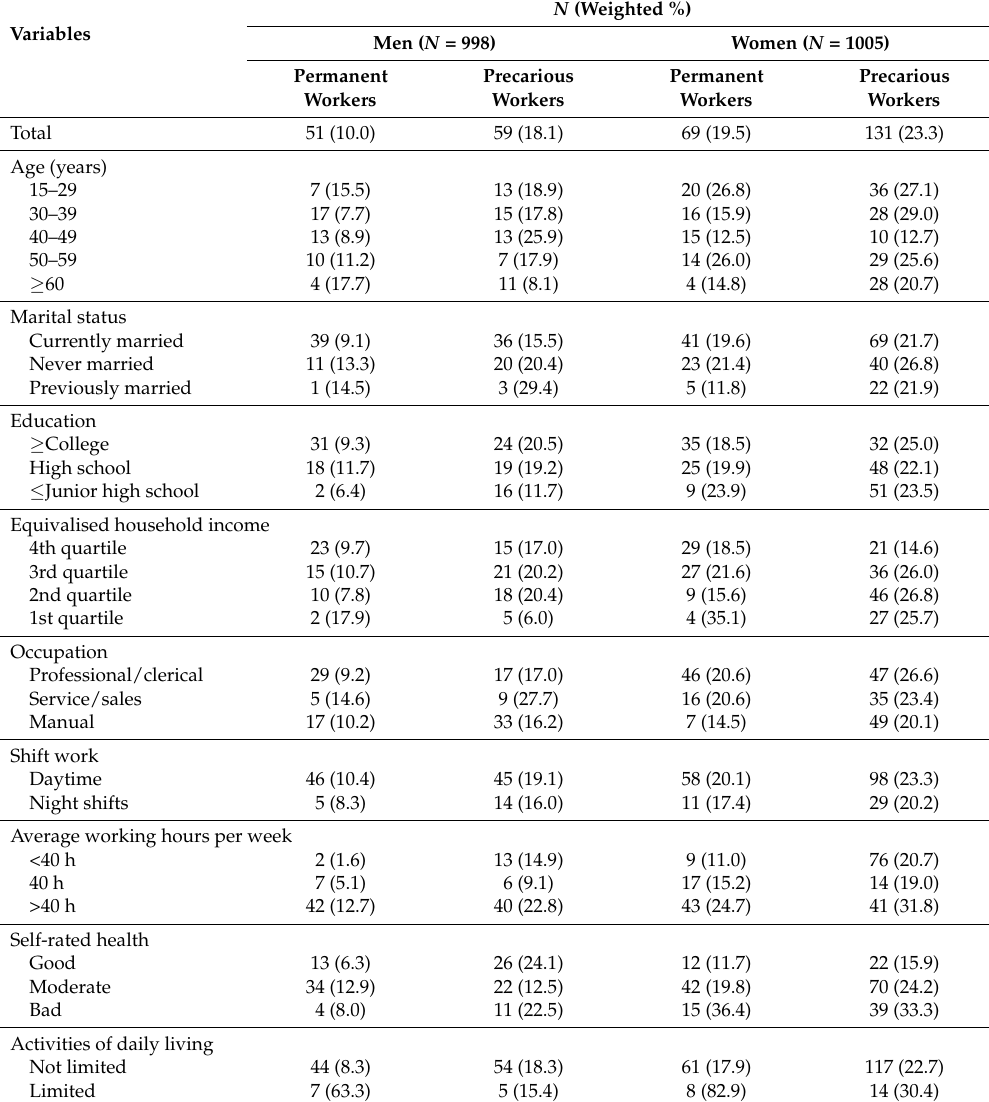
Table 2. The distribution of the prevalence of self-reported unmet healthcare needs of study subjects by sex and employment